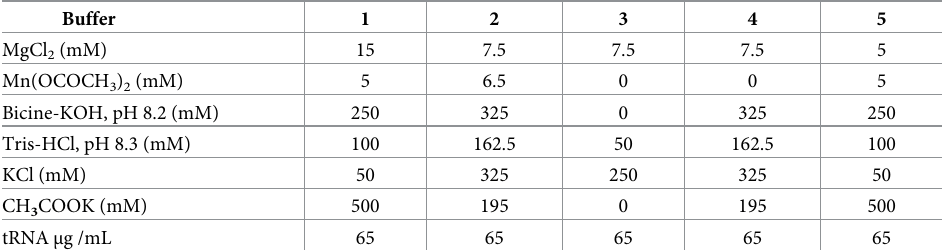
Table 1. The composition of five different 5 × buffers.